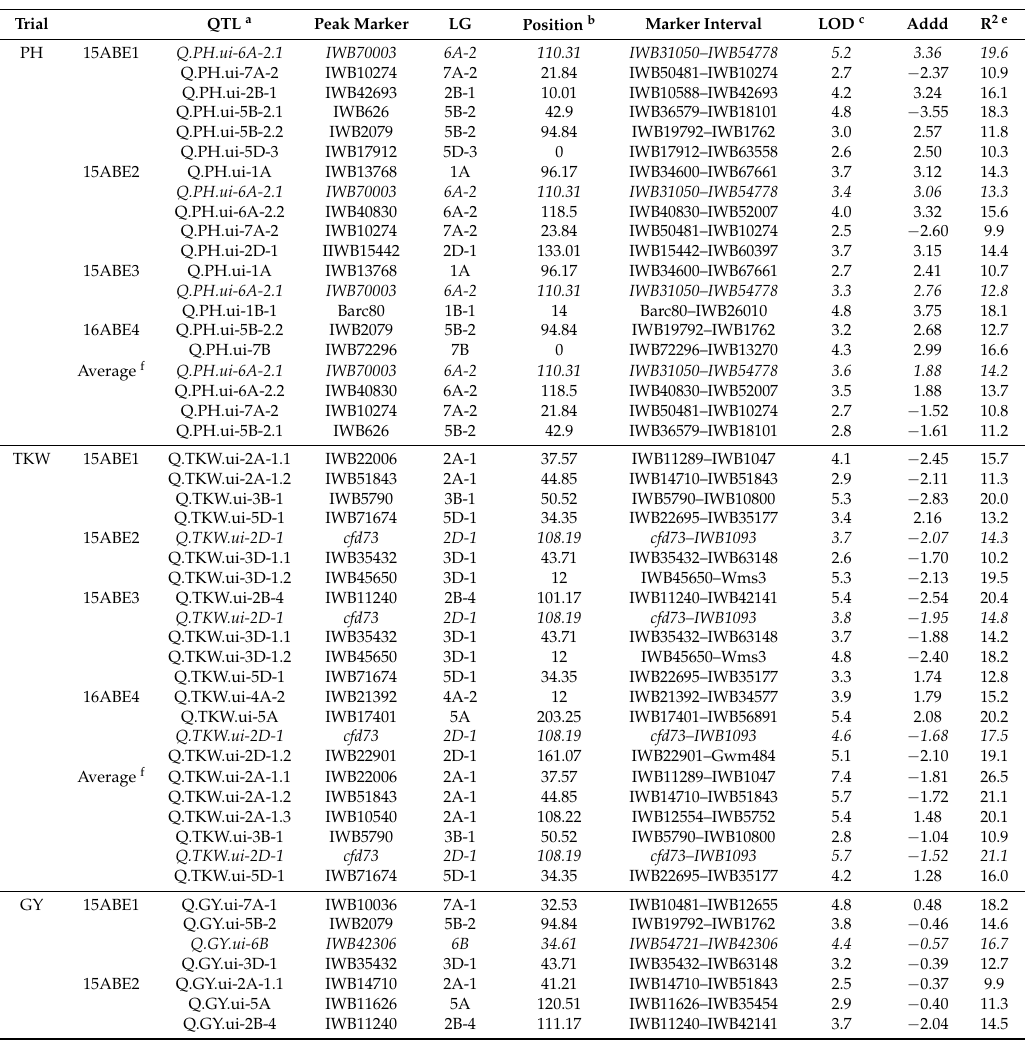
Table 6. QTLs for plant height (PH), thousand kernels weight (TKW) and grain yield (GY) detected in the DH population of UI Platinum/SY